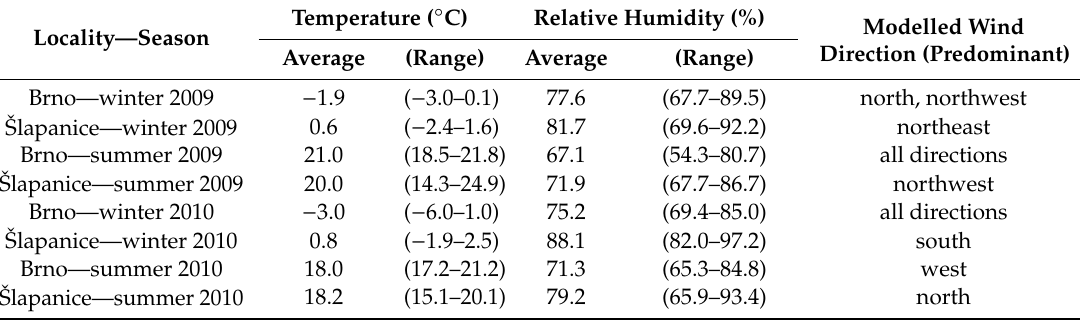
Table 1. Meteorological parameters in Brno and Šlapanice during